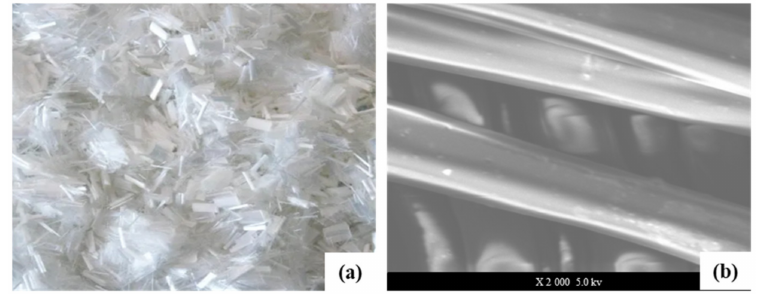
Figure 3. Polyester fiber ( a ), microstructure of polyester fiber ( b